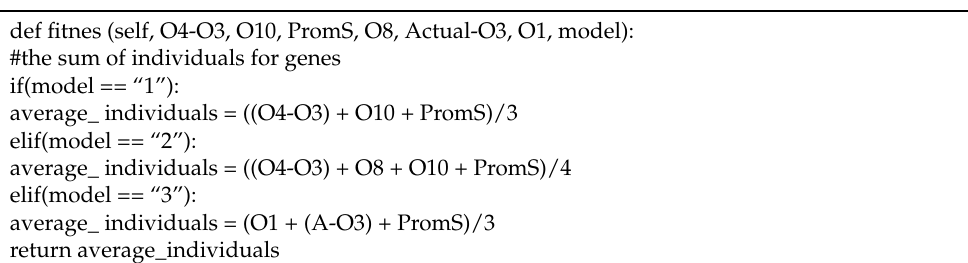
Table 6. Evaluation of the fitness function of the